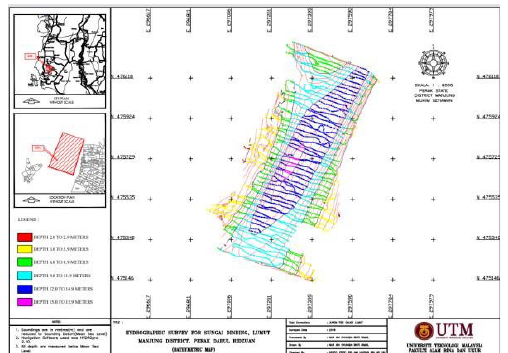
Figure 12. Bathymetric plan relative to the DSMM tide gauge in 2018 plotted using AutoCAD